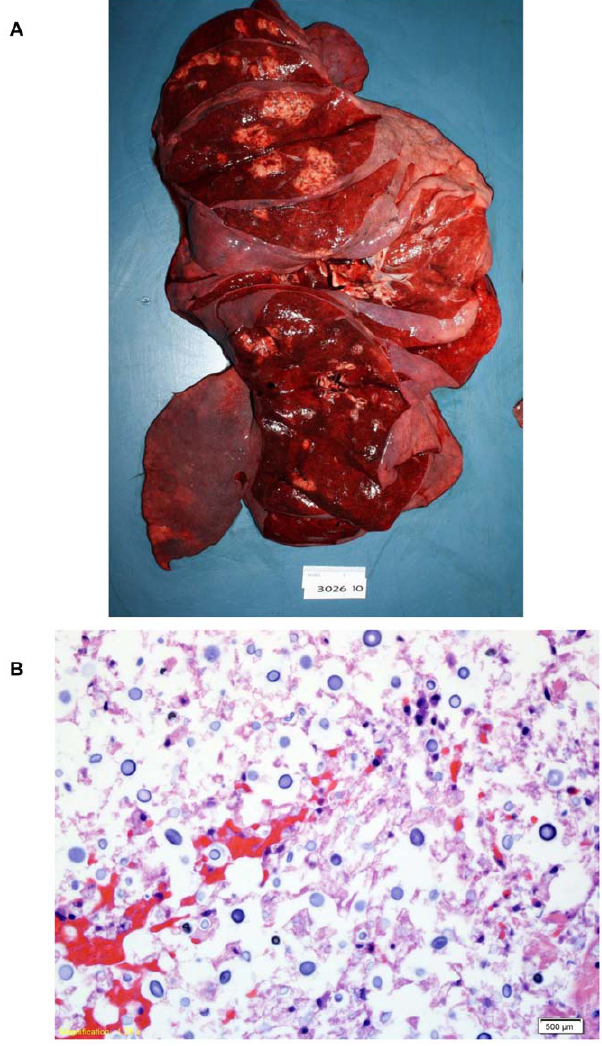
Figure 2. Postmortem examination of the lungs reveals multiple cryptococcal lesions. a. Postmortem examination of the lungs revealed multiple yellow-tan ill-defined masses throughout all lobes of the lungs. b. Histopathologic examination of the lungs demonstrated scattered interstitial and intravascular encapsulated yeasts morphologically consistent with Cryptococcus